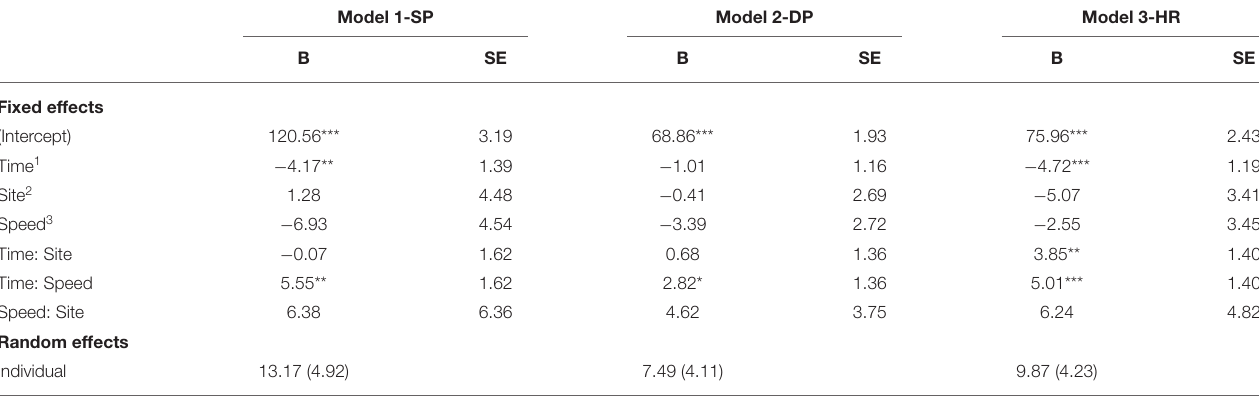
TABLE 2 | Multilevel modeling results for the effects of walking conditions on physiological indices, including systolic blood pressure, diastolic blood pressure, and heart rate.